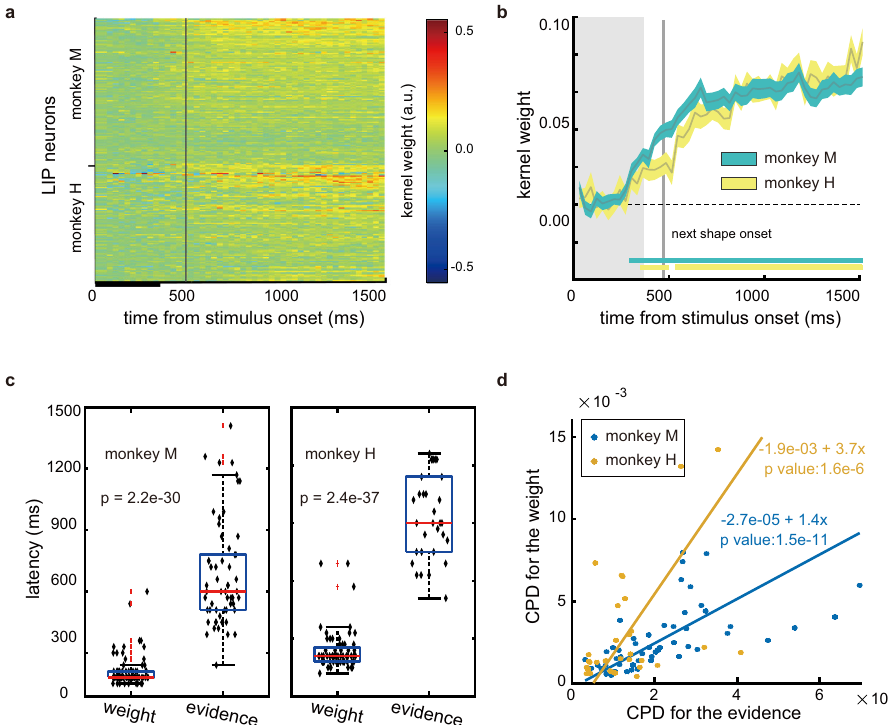
Fig. 4 | LIP neuronsencodedevidence. a Response kernels forevidencebased on thePoissonGLM.Eachrowisaneuron.Redandblueindicatepositiveandnegative kernel weights, respectively. Many neurons show positive kernel weights (monkey M: 58 out of 115, monkey H: 32 out of 92), indicating that evidence in favor of T in increased their responses. Neurons are indexed in the same order as in Fig. 3b. b Populationevidencekernels. The curve width denotesS.E. acrossunits. The bars along the abscissa indicate the periods when the kernel weights are signi fi cantly different from 0 (two-tailed t tests, p <0.01). The grey vertical lines in a and b indicate the onset of the nextstimulus. c The encodinglatenciesofshape weight and evidence.Each dot denotes aneuron. Onlyneurons with signi fi cant encodings